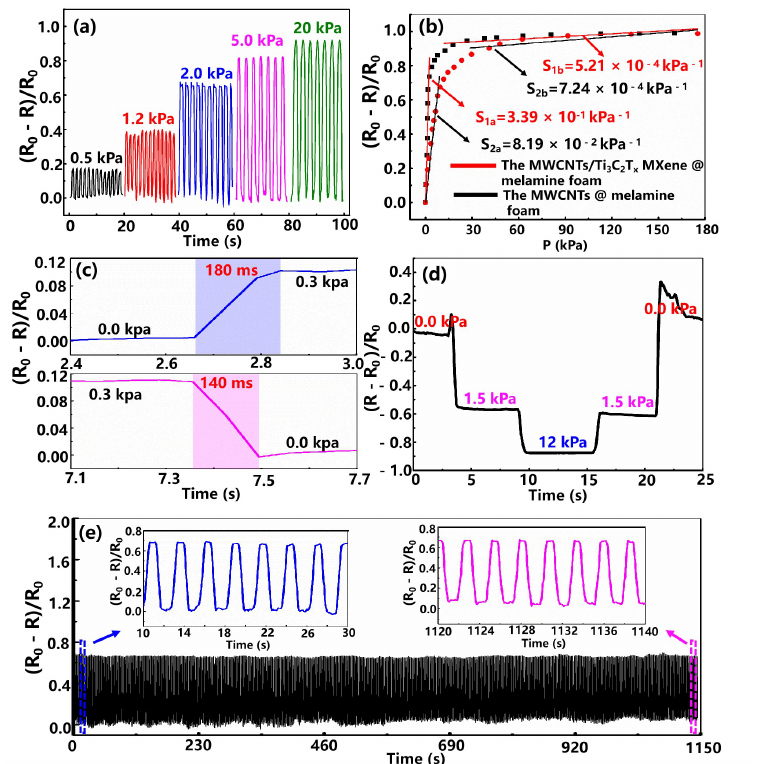
Figure 2. Performance characterization of the fabricated flexible pressure sensors. ( a ) Relative resistance variation of the MWCNTs/Ti 3 C 2 T x MXene @ melamine foam under serial pressures below 25 kPa. ( b ) Relative resistance change vs. the applied pressure of the different types of foam-shaped sensors. ( c ) The response/recovery time of the fabricated foam-shaped device is under 0.3 kPa. ( d ) The relative resistance change of the fabricated foam-shaped composite sensor under step-applied pressure. ( e ) Durability performance of the fabricated device under the pressure of 2 kPa at a frequency of 0.4